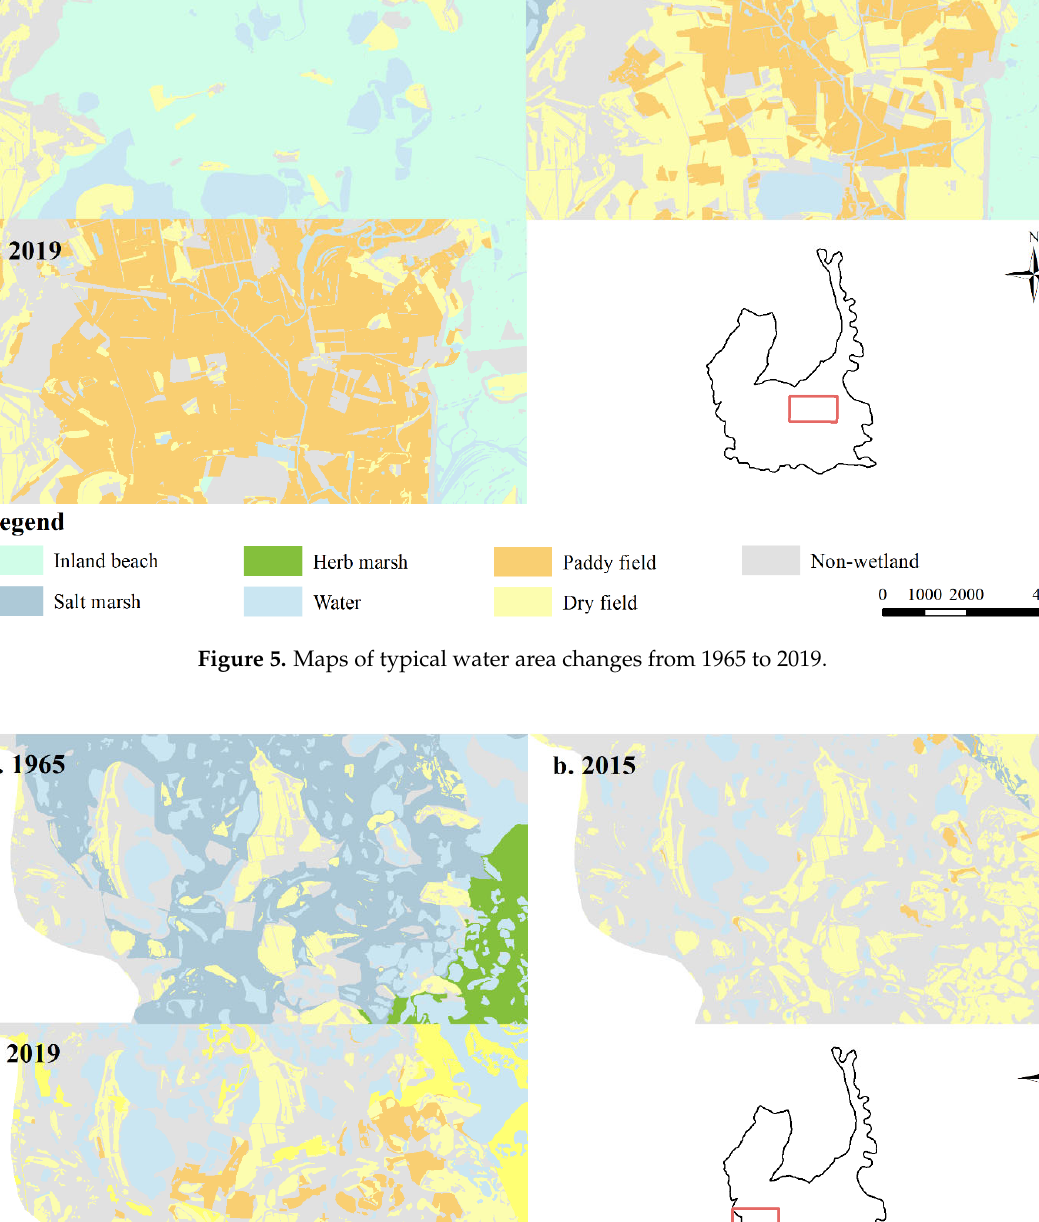
Figure 7. Momoge Internationally Important Wetland dynamic land use change map. From 1965 to 2019, land use in the Momoge Internationally Important Wetland changed greatly (Figure 8), and the rates of change for different types of land were very different.